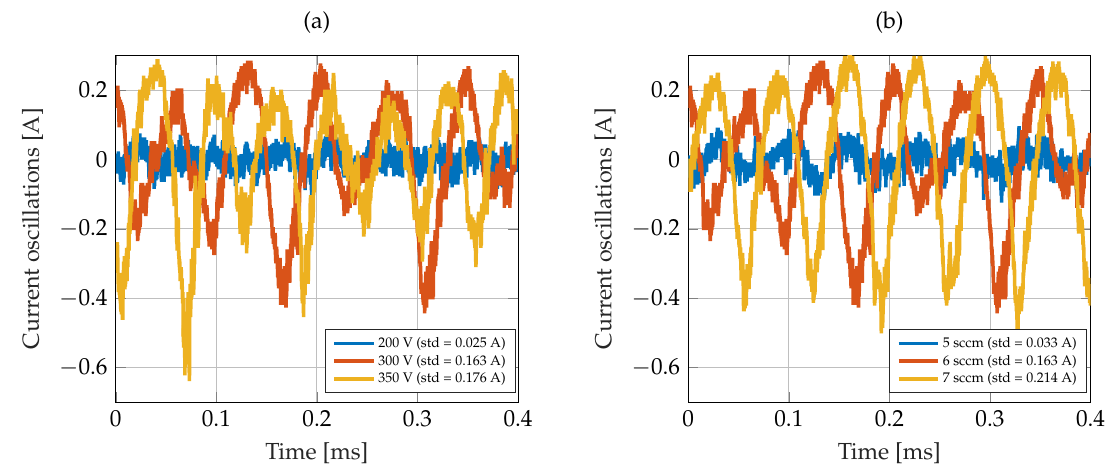
Figure 9. Discharge current oscillations at different operating parameters. (a) shows current oscillations for different discharge voltages at ˙ m a = 6 sccm and (b) shows current oscillations for different anode mass flow rates at U d = 300 V. For each current oscillation, the standard deviation (std) is given. Oscillations are reduced to abscissa axis to have clearer comparison.